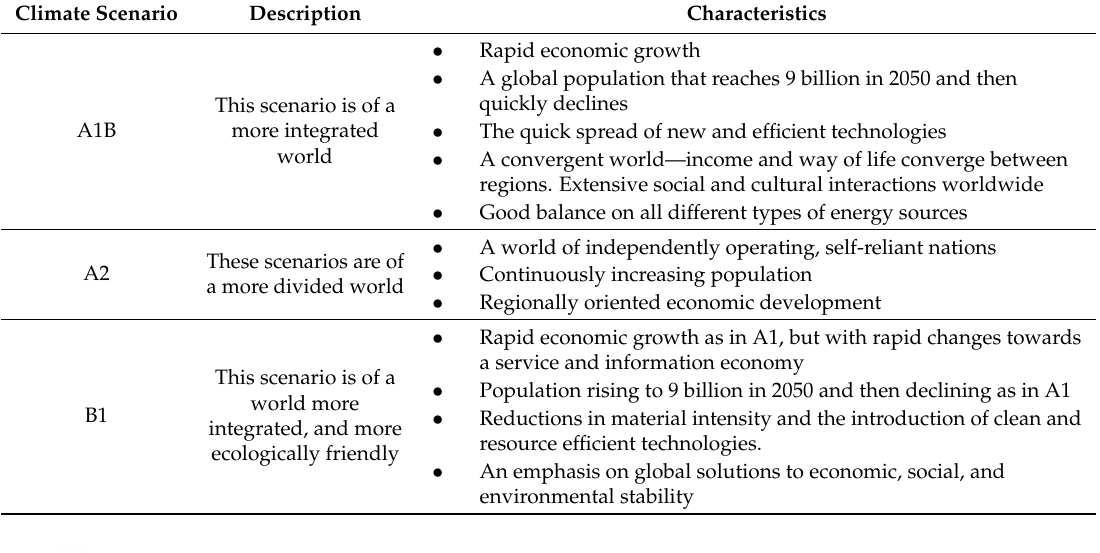
Table 2. Climate scenarios and the associated social, economic, and human theme as presented in AR4.